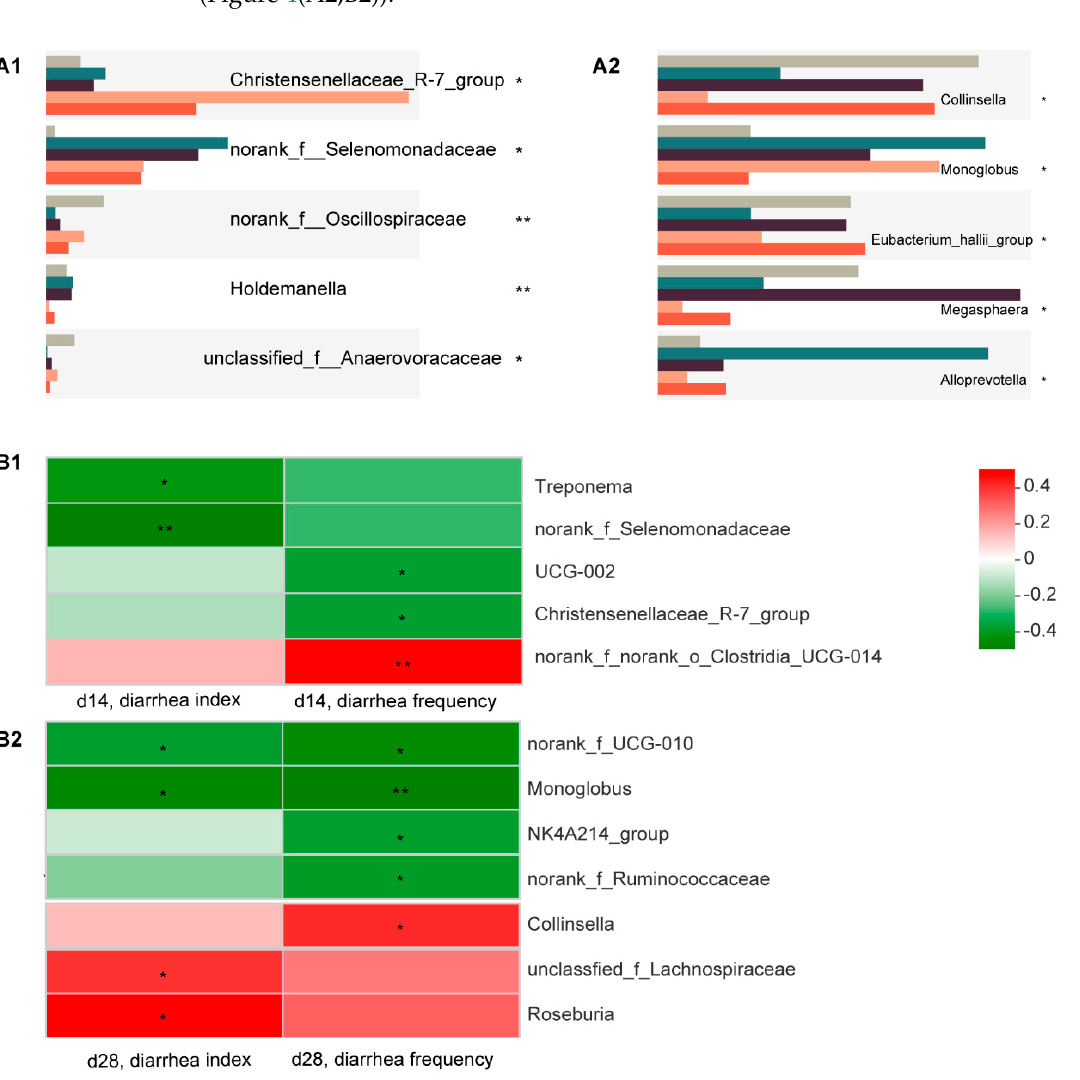
Figure 4. Bacterial targets of Microcin C7. ( A ) Relative abundances of top 5 genera at d 14 ( left ) and d 28 ( right ). An asterisk indicates significant between-group differences (* p < 0.05; ** p < 0.01). ( B ) Correlation matrix between specific taxa and diarrhea-associated parameters at d 14 ( up ) and d 28 ( down ). An asterisk indicates that the correlation is statistically significant (* p < 0.05; ** p < 0.01).